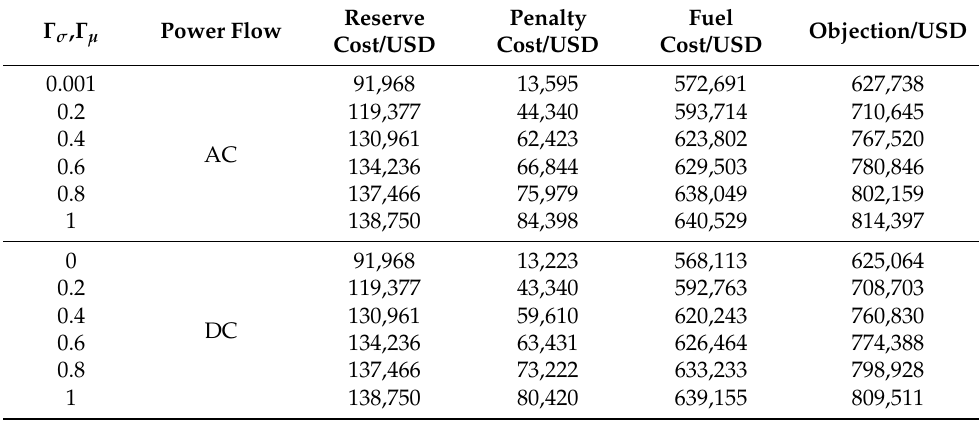
Table 2. Object value of different conservative